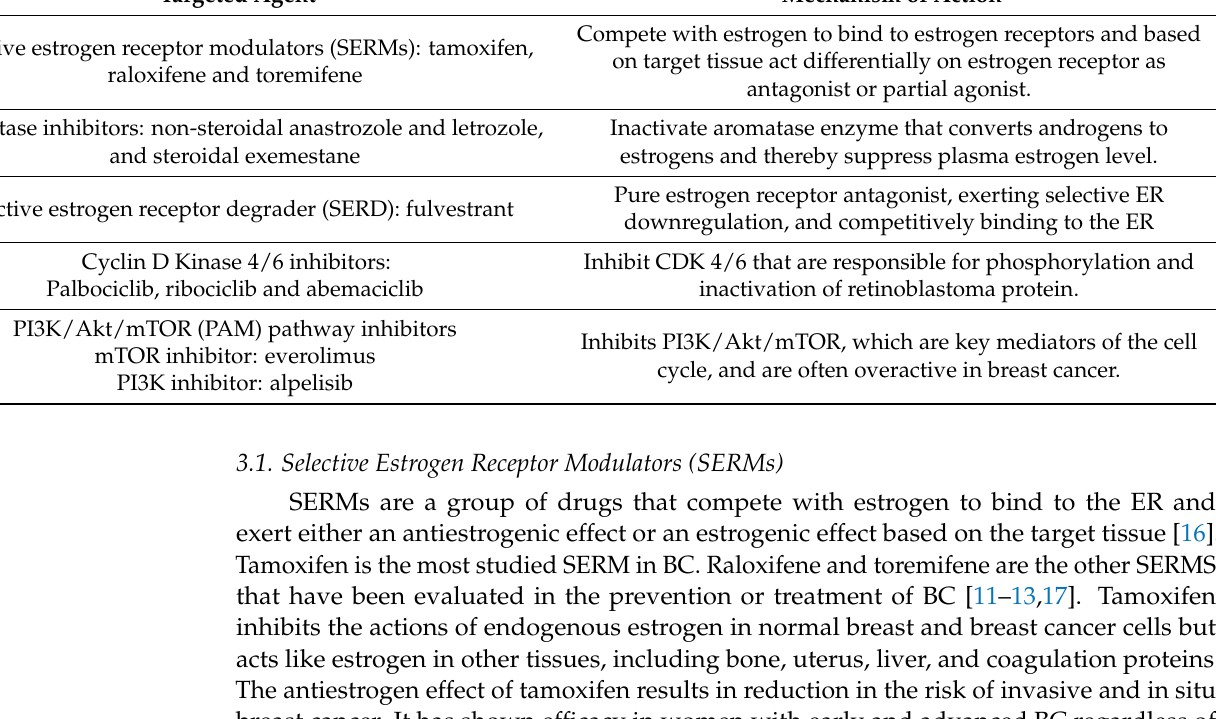
Table 1. Key targeted therapies that are approved in the management of HR + BC. Targeted Agent Mechanism of